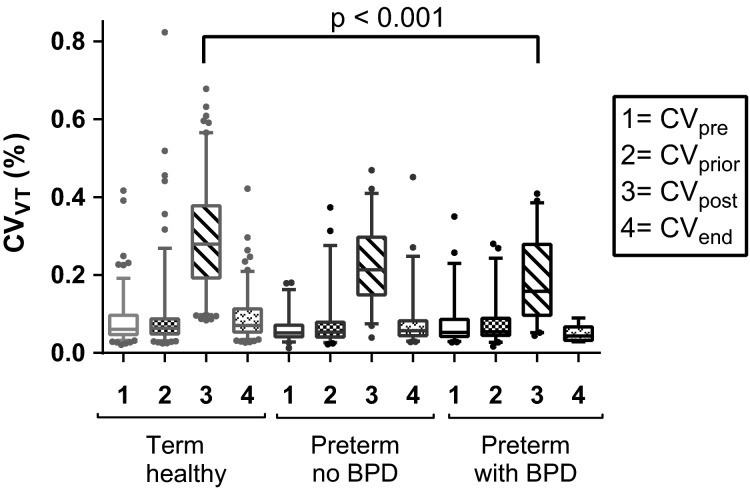
Short-term variation in tidal volume (CVVT) for different subgroups (Term Healthy; Preterm infants without BPD at 36 weeks GA; Preterm infants with BPD at 36 weeks GA). CVVT was measured using moving window technique at the start of the measurement (CVpre), prior to the sigh (CVprior), just after a sigh (CVpost), and at the end of a measurement (CVend).